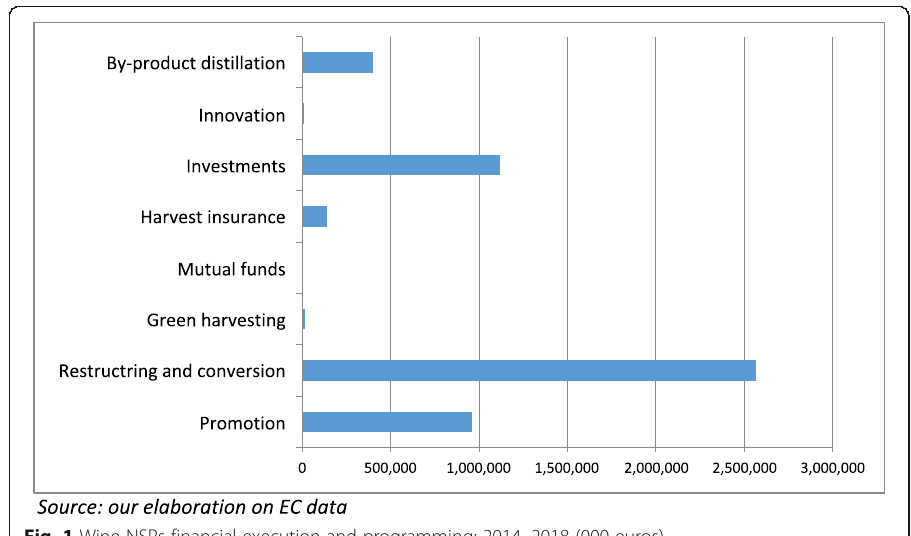
Fig. 1 Wine NSPs financial execution and programming: 2014 – 2018 (000